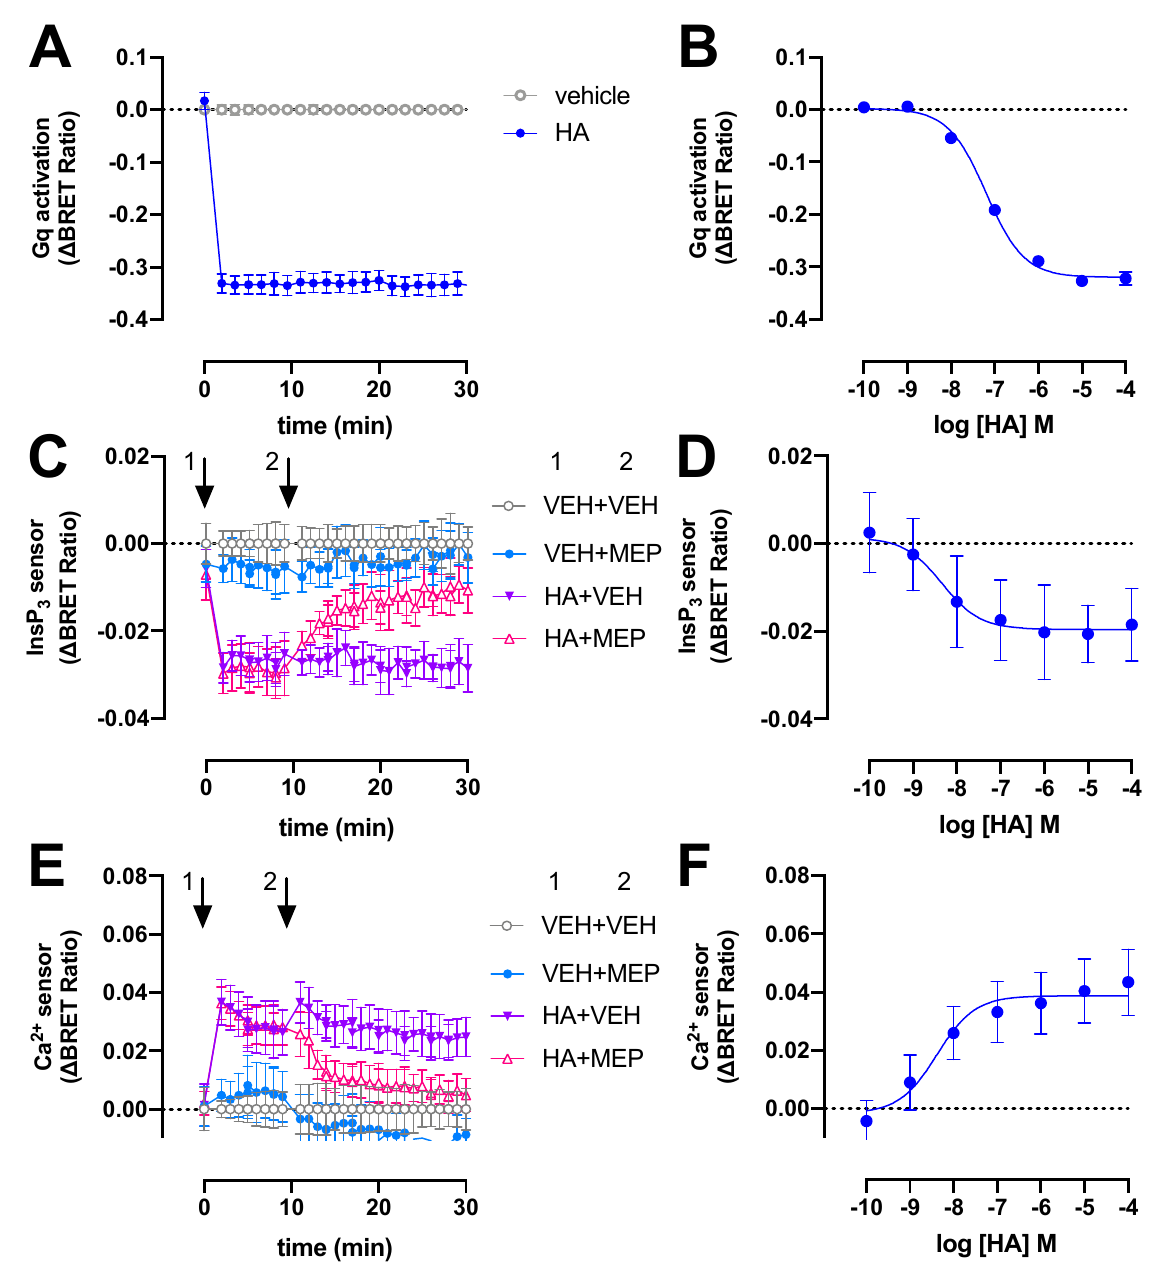
Figure 1. H 1 R activates heterotrimeric G q proteins, InsP 3 production and Ca 2+ release in response to histamine (HA). BRET measurements in HEK293T cells transiently co-expressing H 1 R (0.5–1 µ g plasmid/dish) in combination with the heterotrimeric G q activation sensor (2.5 µ g plasmid/dish) ( A , B ), InsP 3 ( C , D ) or Ca 2+ ( E , F ) sensor (4.0–4.5 µ g plasmid/dish) in real time upon stimulation with 10 µ M histamine ( A , C , E ) or after 20-min stimulation with increasing concentrations histamine ( B , D , F ). InsP 3 and Ca 2+ cells were first stimulated with vehicle (VEH) or histamine (HA) at t = 0 min followed by a second injection of vehicle (VEH) or 10 µ M mepyramine (MEP) at t = 10 min, indicated by the numbered arrows 1 and 2, respectively ( C – E ). Data are shown as mean ± SD from at least three independent experiments performed in triplicate. The potency (pEC 50 = 7.2 ± 0.1; mean ± SD; n = 4) of histamine to activate het- erotrimeric G q proteins in our BRET assay is approximately 4-fold lower than previously observed in a G protein-based transforming growth factor- α shedding assay (Figure 1B) [28]. Surprisingly, a 50-fold lower histamine potency was reported in essentially a similar BRET readout between G α q -Renilla luciferase 8 (Rluc8) and the G β 3 G γ 9 -green fluorescent